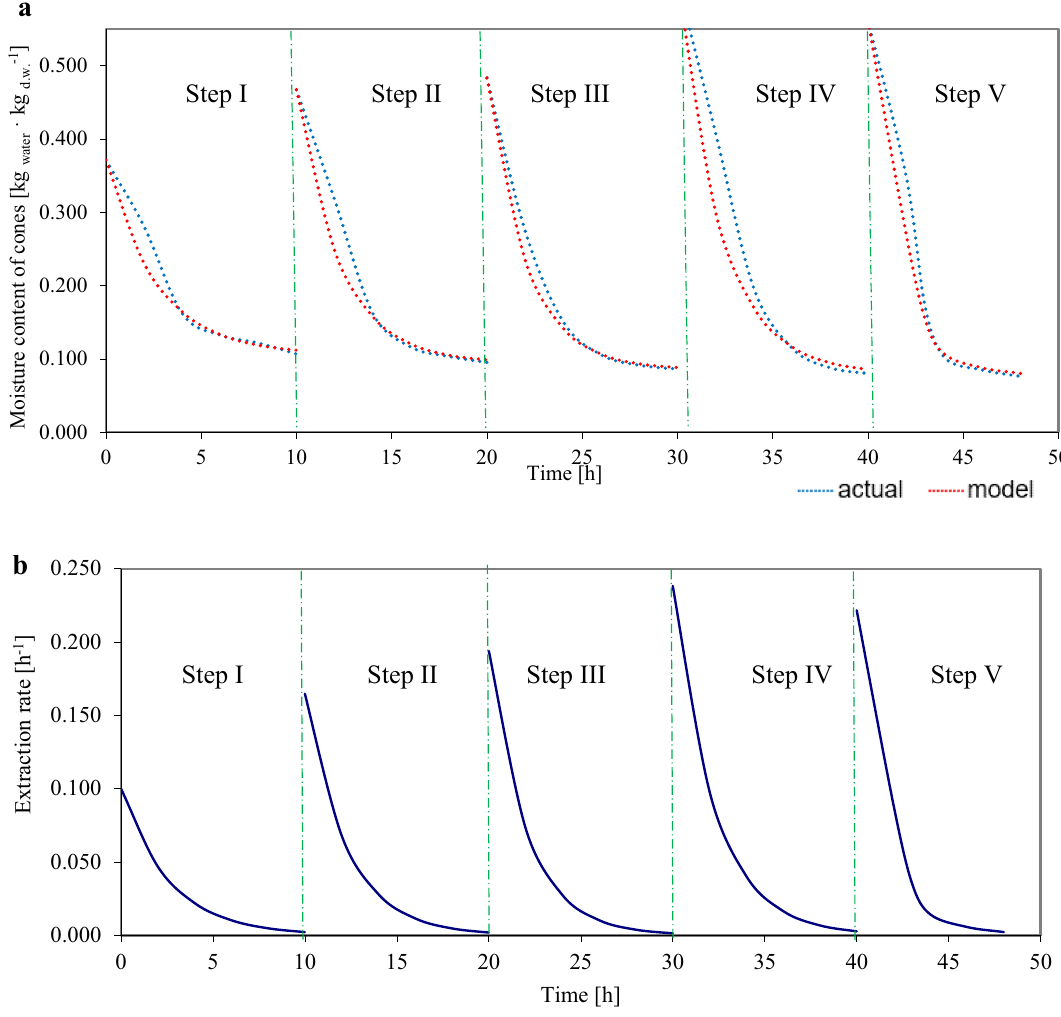
Figure 2. Diagrams: ( a ) actual and predicted changes in cone moisture content, ( b ) extraction rate in five extraction steps for larch cone no. 32 in the 10 h_15 min variant throughout effective